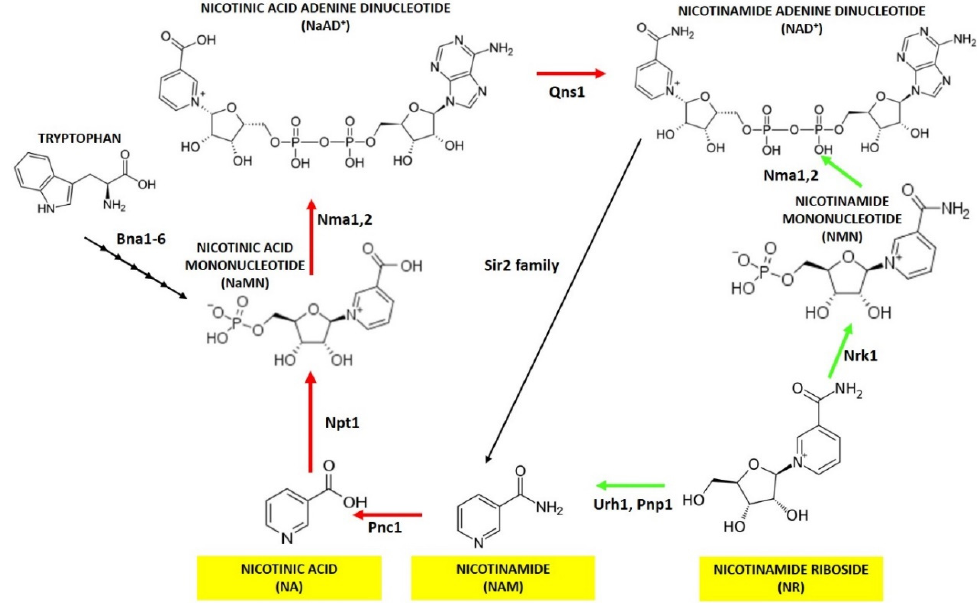
Figure 1. NAD + synthesis in yeast. A schematic view of the pathways involved in NAD + biosynthesis. In yeast NAD + can be obtained through the de novo pathway starting from tryptophan or through salvage pathways from nicotinic acid (NA), nicotinamide (NAM) and nicotinamide riboside (NR) evidenced in yellow boxes. Abbreviations of enzyme names, that catalyze each step of NAD + biosynthesis, are reported. The Preiss-Handler pathway is indicated by red arrows while NR utilization is indicated by green ones.